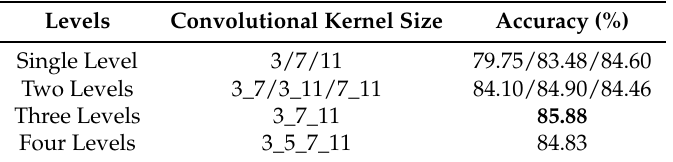
Table 1. Comparison of different levels and convolutional kernel sizes xResNet in accuracy, the best result is in bold.